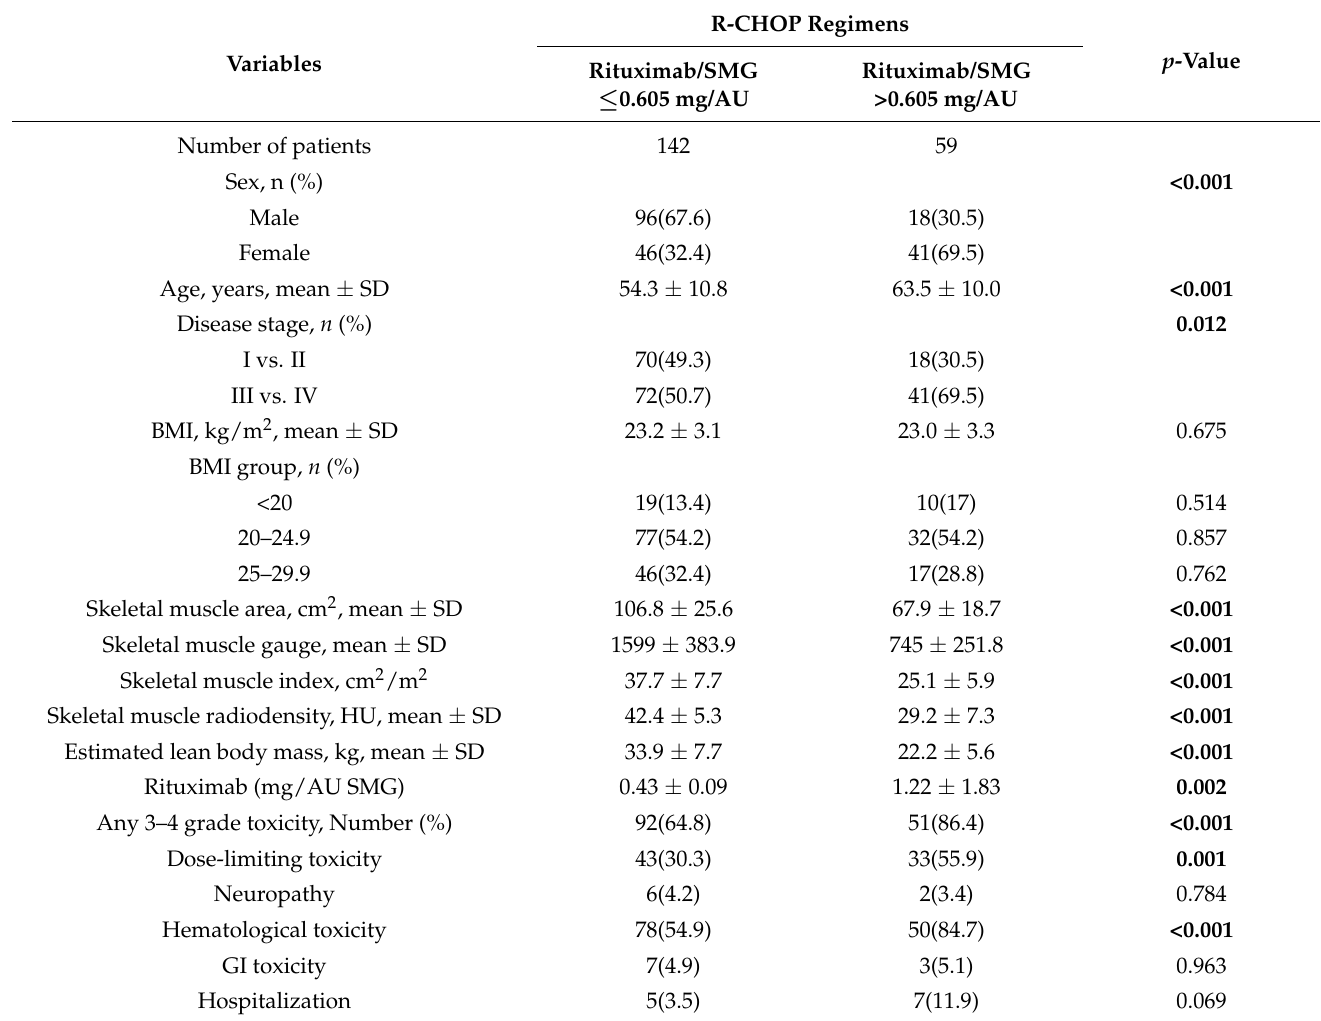
Table 3. Comparison of patients who received Rituximab per AU